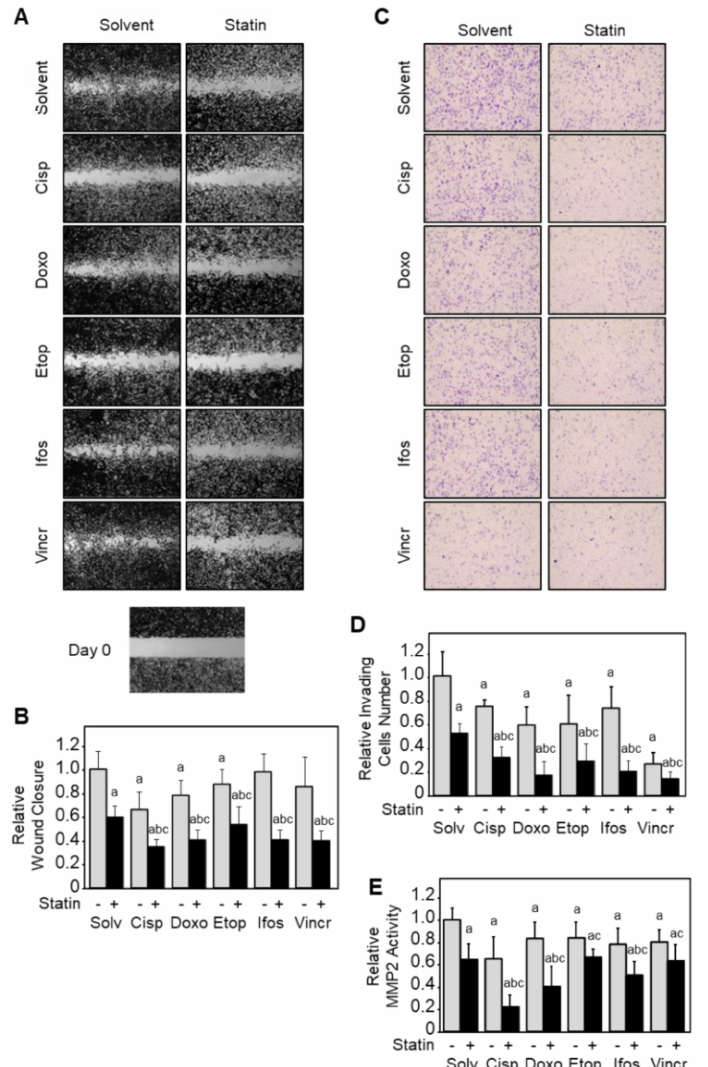
Figure 7. Chemotherapy drugs and simvastatin synergistically reduce osteosarcoma cell invasiveness in vitro. ( A ) Cell motility evaluated by wound-healing assay. Cells were exposed to the single or combined indicated compounds in the presence of the broad caspases inhibitor zVAD-fmk (20 µ M). Pictures were taken at times 0 and 18 h after the wound. ( B ) Relative migrating cell number in wound-healing assay. Results are expressed as mean ± SD ( n = 3–4) of two independent experiments. ( C ) Cell invasion evaluated by Matrigel-coated Boyden chambers. Cells were exposed to the indicated single or combined compounds for 16 h. ( D ) Relative invading cell number. Results are expressed as mean ± SD ( n = 3) of two independent experiments. ( E ) Matrix metalloproteinase 2 (MMP2) activity evaluated by a colorimetric assay. Cells were exposed to the single or combined indicated compounds for 24 h. Results are expressed as mean ± SD ( n = 5–6) of two independent experiments. a: p < 0.05 compared to untreated, b: p < 0.05 compared to simvastatin alone, c: p < 0.05 compared to chemotherapy drug